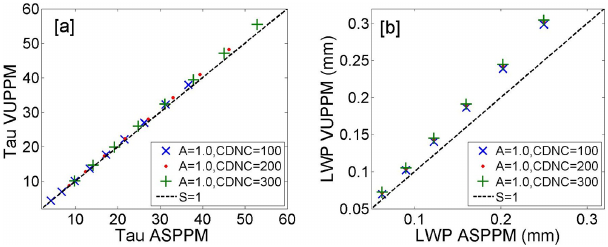
Fig. 11. Comparison of retrieved cloud optical depth (Tau) and Cloud liquid water path (LWP) from VUPPM with ASPPM for cloud drop number concentrations (CDNC) of 100, 200, and 300cm − 3